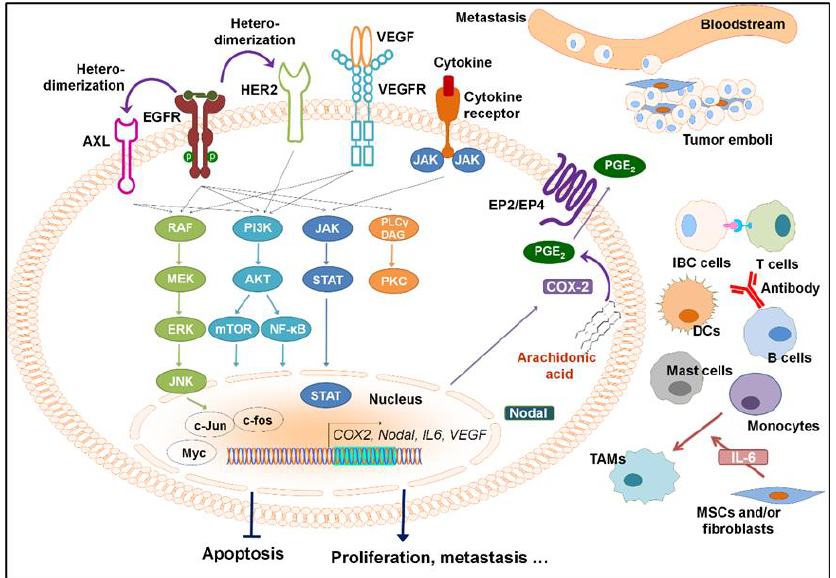
Figure 1. Overexpressed or activated signaling pathways in inflammatory breast cancer and the tumor microenvironment. The presence of tumor emboli, in which cells pack together to form a tumor cell cluster, is a hallmark of IBC cells. DCs, dendritic cells; IBC, inflammatory breast cancer; MSCs, mesenchymal stem cells; TAMs, tumor-associated